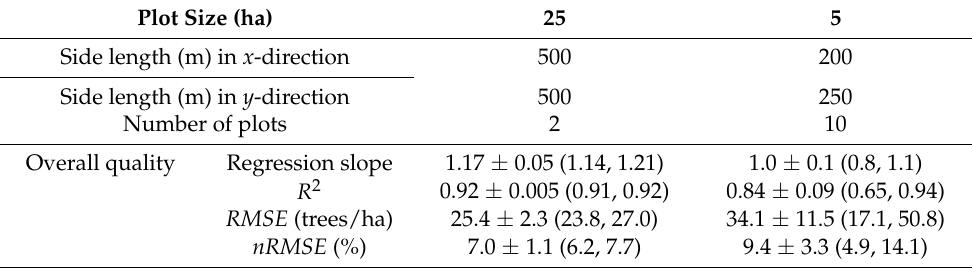
Figure A4. Spatial maps and histograms of the statistics on RMSE (trees/ha), nRMSE (%), and regression slope for the estimation of stem diameter distributions from lidar, ( a – c ) at the 1-ha scale, ( d – f ) at the 0.25-ha scale, and ( g – i ) at the 0.04-ha scale at BCI. Green colors denote the optimal values (note different value ranges for the different spatial scales and statistics). Black vertical lines in the histograms show the median. Table A2. Comparison of the forest attributes derived from lidar and from the forest inventory for different plot sizes. Results are shown for the regression analysis (slope and R ²), RMSE and nRMSE (overall and for three different categories of small, mid-sized and large trees grouped according to the stem diameter d ) and aggregated forest attributes (tree density and basal area, for stem diameter d ≥ 10 cm). For each plot size, the mean ± standard deviation (and in brackets, the minimum and maximum) of the respective attribute is given. The plot size is given in ha with the number of plots and plot dimension in m × m. Forest attributes are compared between lidar and inventory also in terms of the bias , RMSE , and nRMSE (%) (see methods for details).